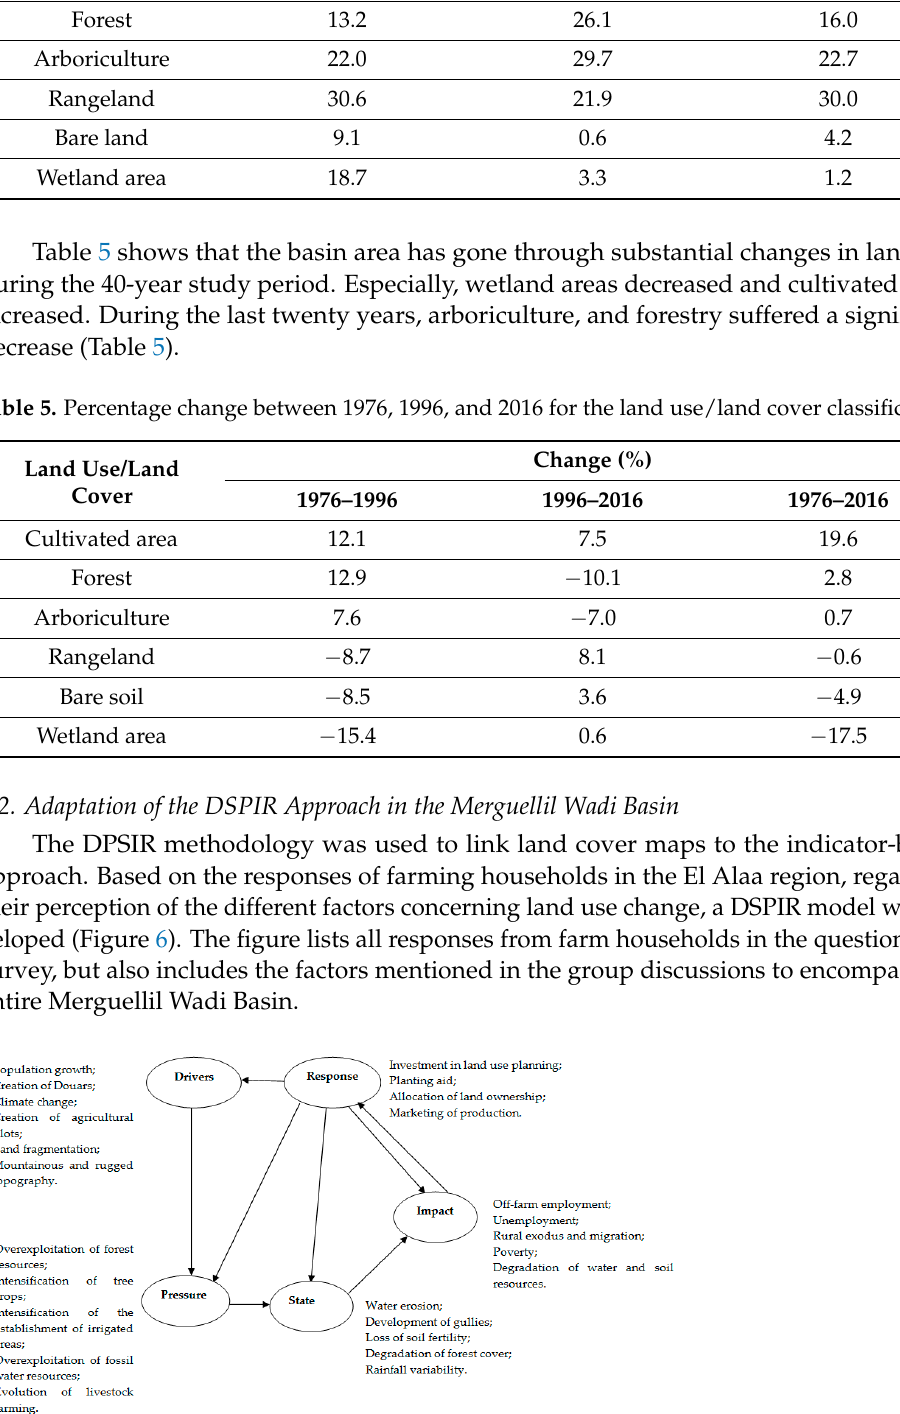
Figure 6. Adaptation of the DPSIR framework to household experienced land use changes in the Merguellil Wadi Basin.